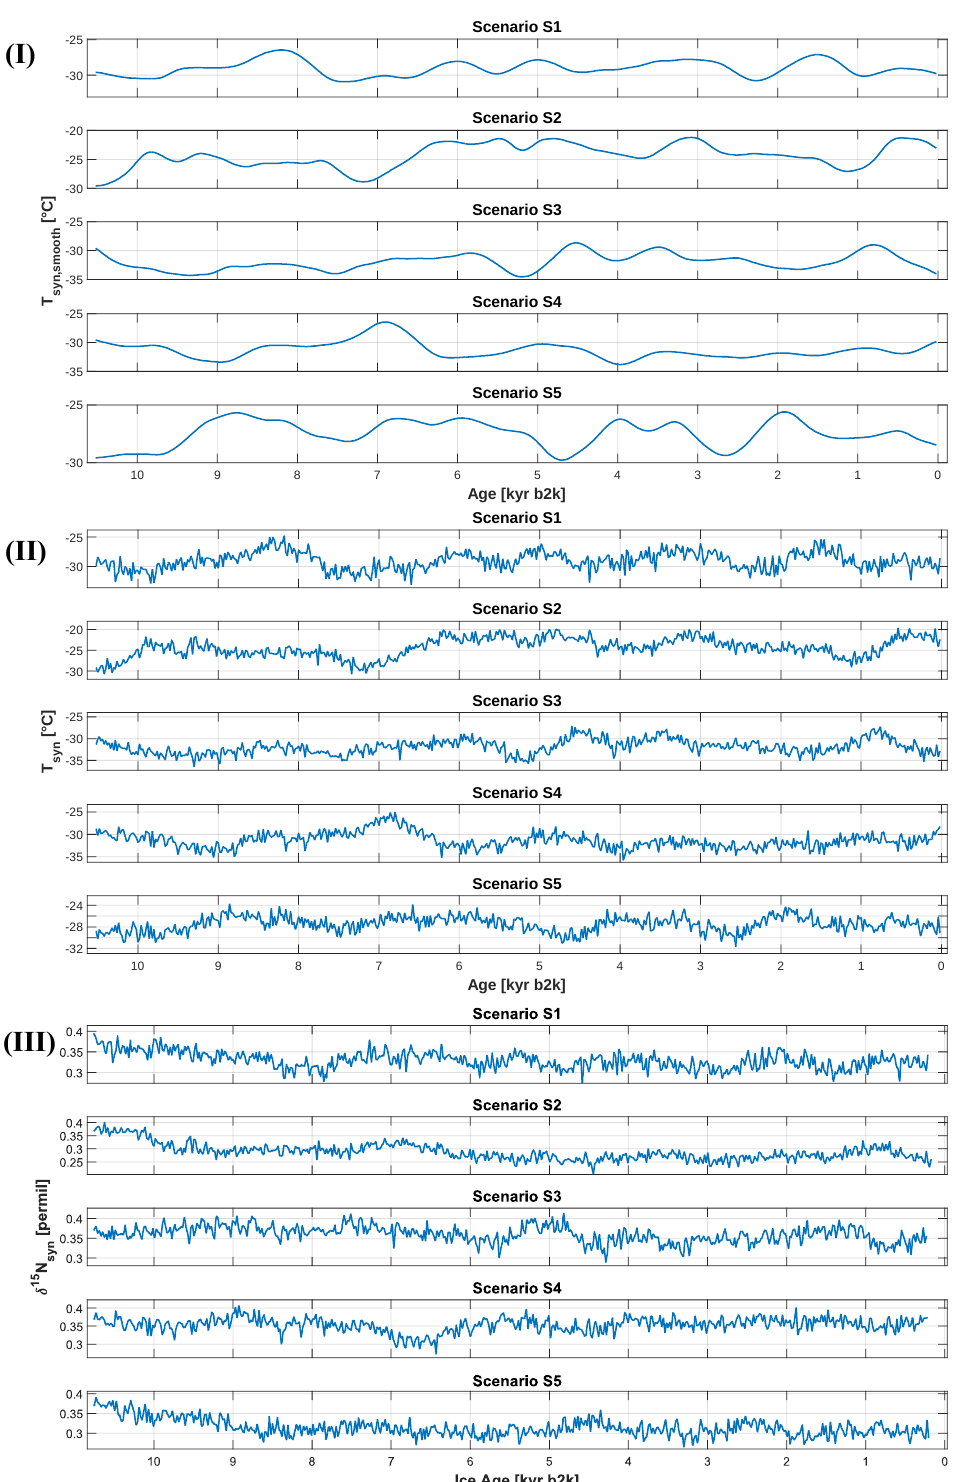
Figure 4. (I) S1–S5: synthetic smooth temperature scenarios for the construction of the target-temperature data. (II) S1–S5: synthetic target surface-temperature scenarios. (III) S1–S5: corresponding synthetic δ 15 N target time series.